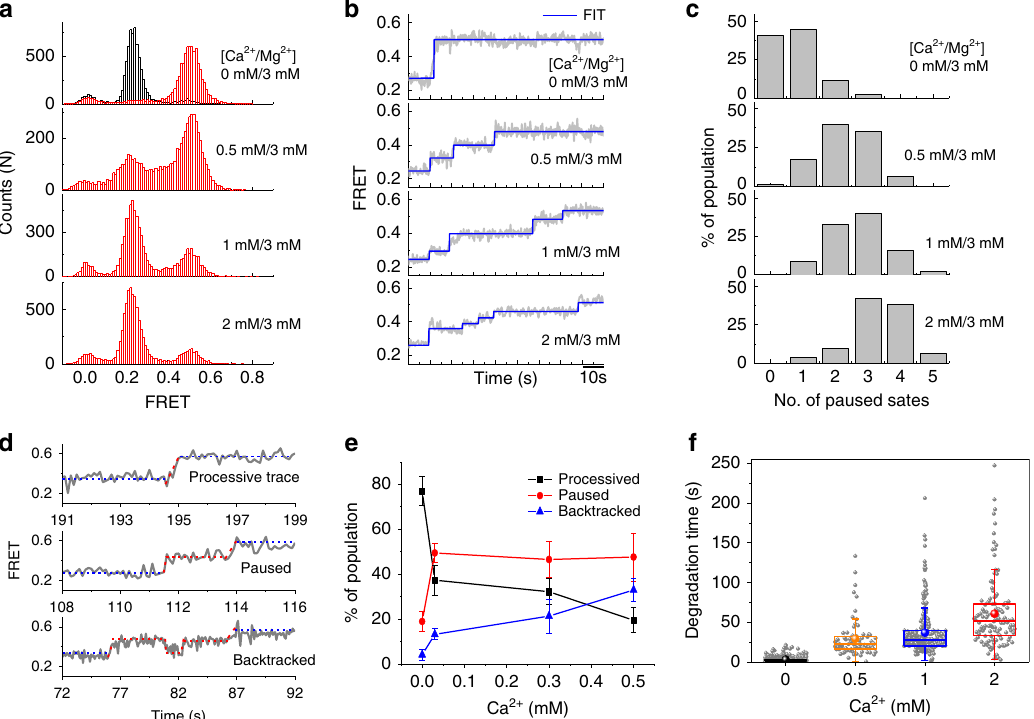
Fig. 3 Inhibition of λ -exonuclease activity by Ca 2 + ions. a Single-molecule FRET histograms with various concentrations of Ca 2 + at the fi xed concentration of 3 mM Mg 2 + . b Ca 2 + -substitution-induced pause behavior fi tted with an automated step- fi nding algorithm. c Pause histograms obtained from various Ca 2 + concentrations at the fi xed concentration of 3 mM Mg 2 + . d Three degradation patterns with pauses and backtracking when inhibited by Ca 2 + . e The proportion of pause and backtracking as a function of Ca 2 + concentration. f Increase in the degradation time with increasing concentration of Ca 2